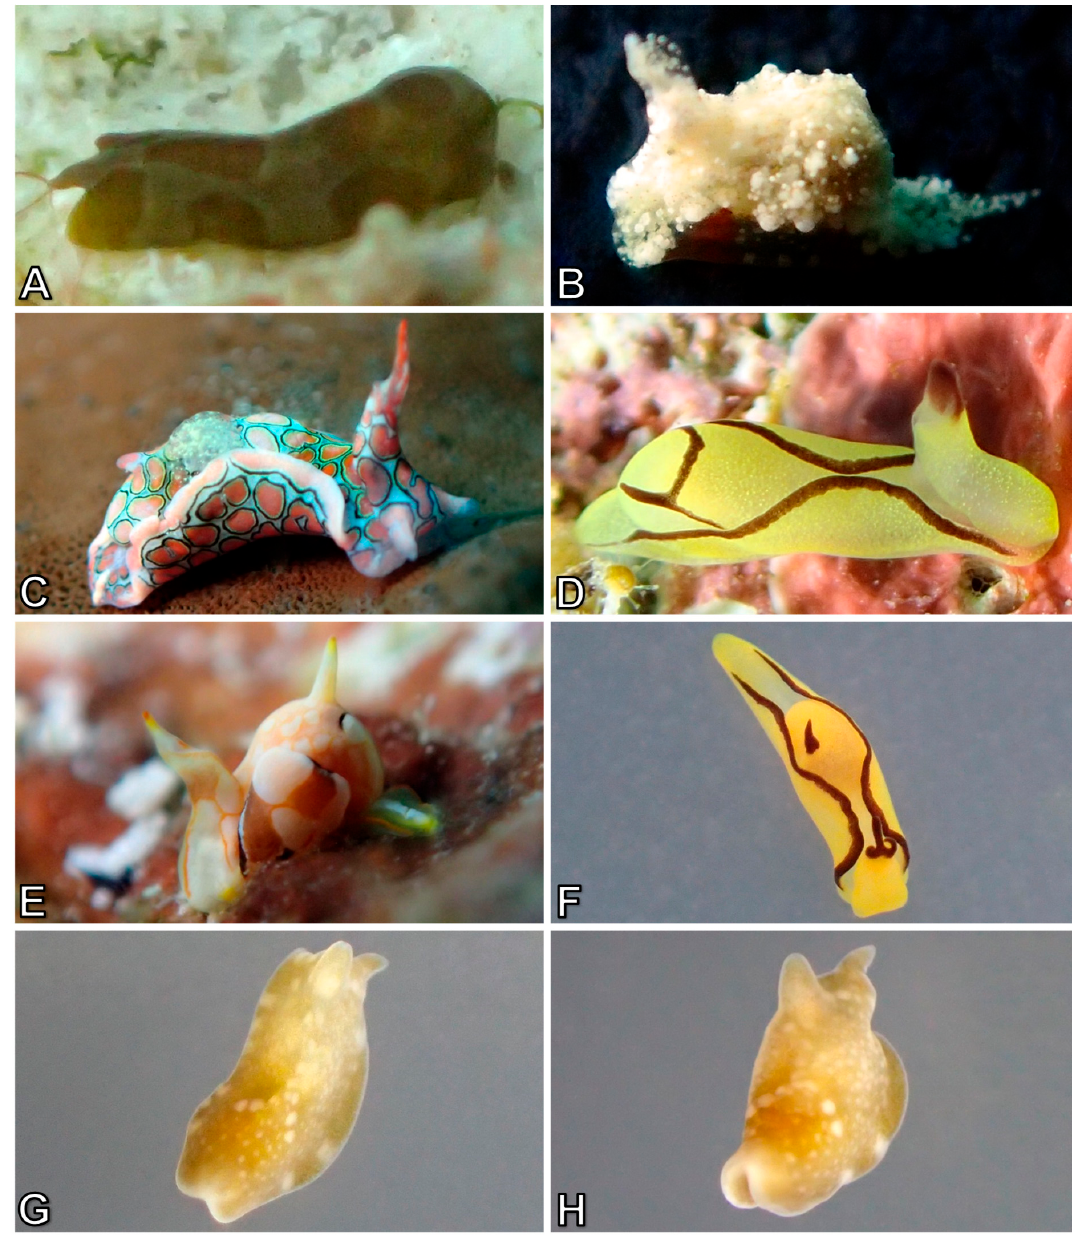
Figure 3. Cephalaspidea and Runcinacea: ( A ) Tubulophilinopsis spec., Phisp16Bu-1; ( B ) Gastropteron spec. ( Gastropteron sp. 5 in Gosliner et al. [11]: 56), Gasp5_16Bu-1; ( C ) Sagaminopteron psychedelicum ; ( D ) Siphopteron brunneomarginatum ; ( E ) Siphopteron ladrones ; ( F ) Siphopteron nigromarginatum ; ( G , H ) Runcina spec., Rusp16Bu-1.